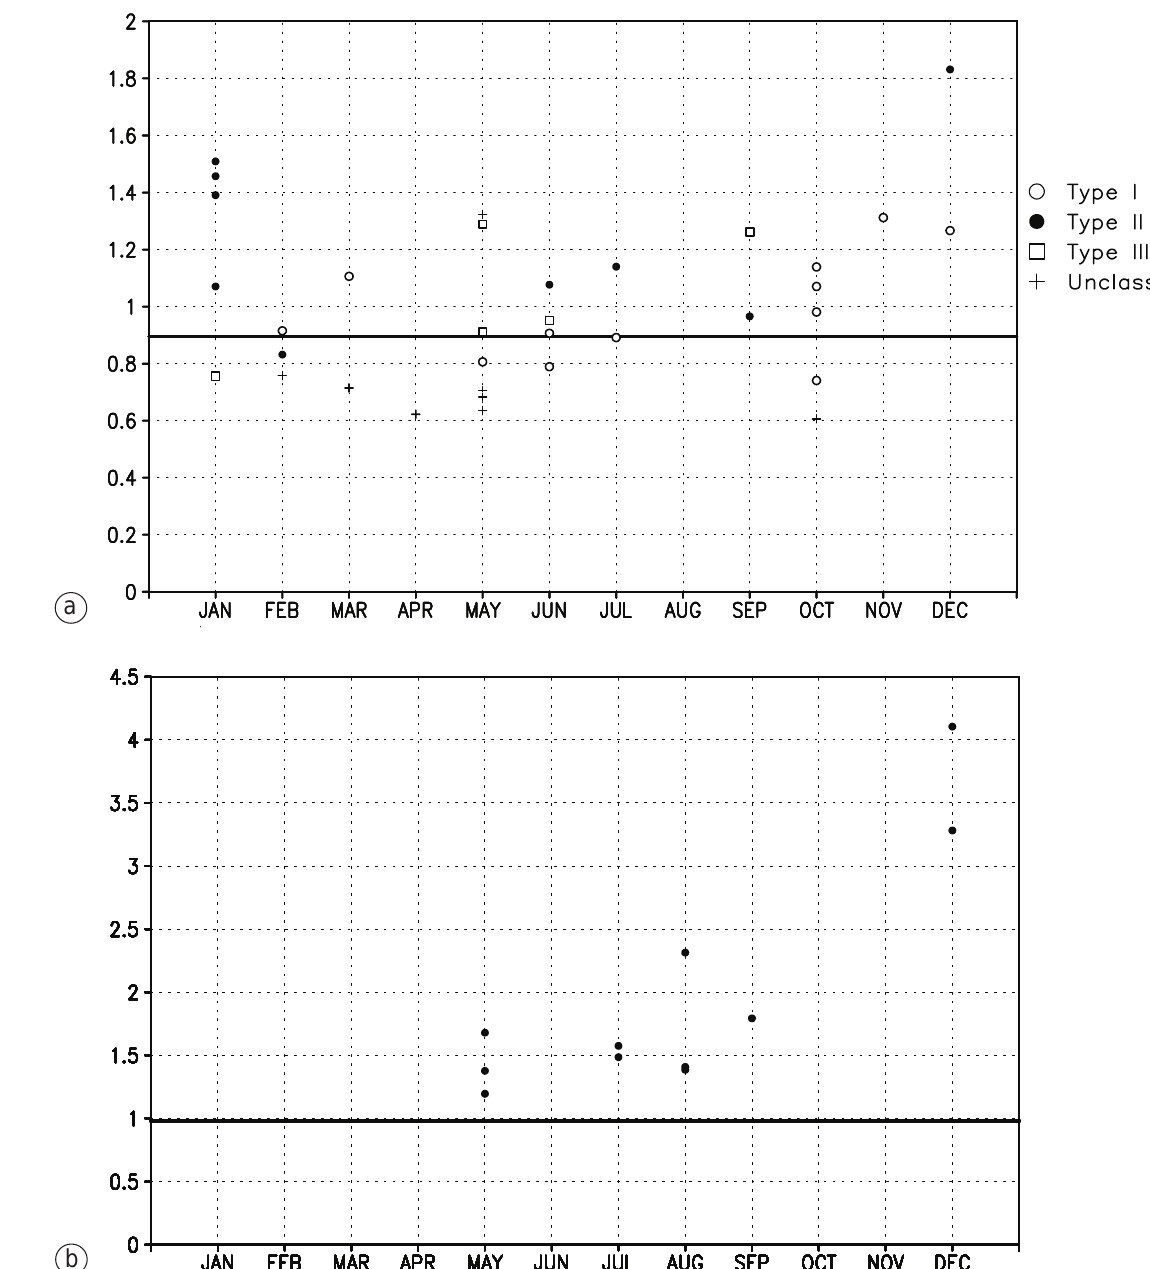
Fig. 3a,b. a) Seasonal distribution of warm SST anomaly peaks in the SINTEX simulation. The horizontal line marks the 1.5 standard deviation threshold for the Niño3 Index; b) as in (a), but for the observed SST anomalies (COADS + IGOSS, 1950-1999)